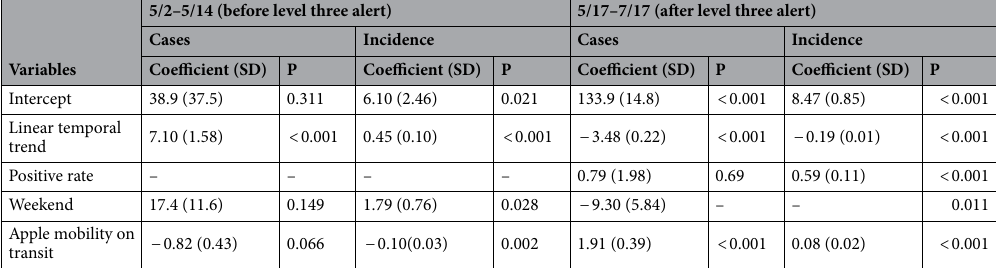
Table 1. The policy effect on the daily COVID-19 cases and incidence at city level.